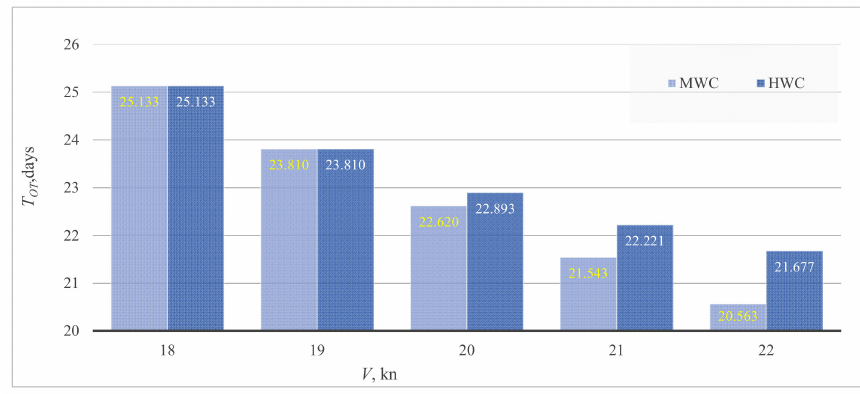
Figure 19. Time interval of one trip under MWC and HWC depending on the sailing speed.